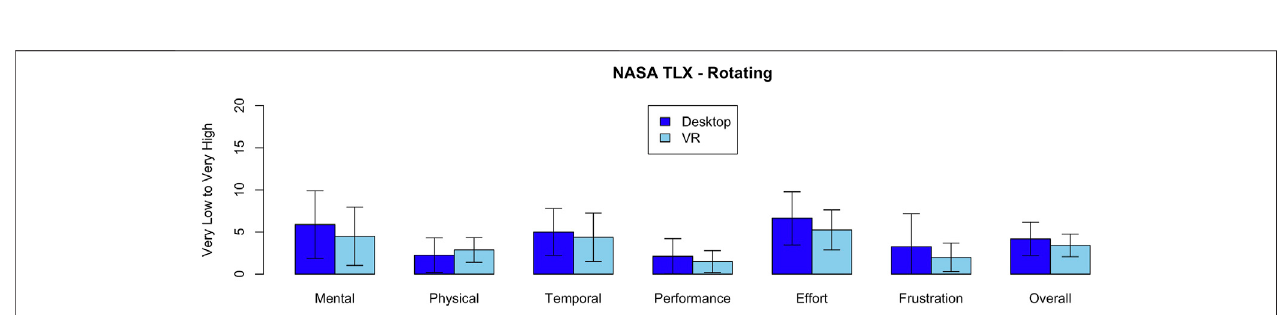
FIGURE 10 | Task 3: TLX values for the rotation task comparing the Desktop and the VR condition.